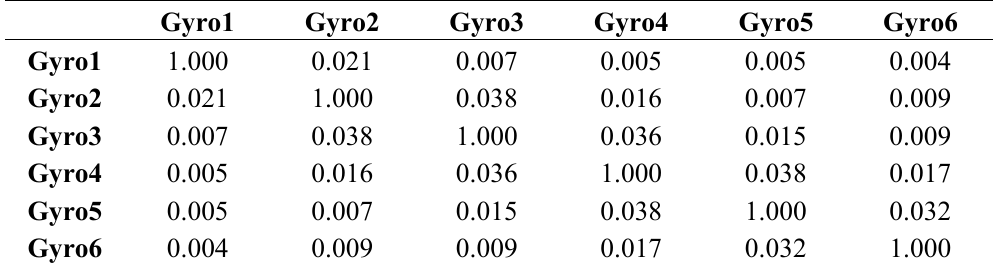
Table 1. Correlation matrix of noises for six-gyro array.